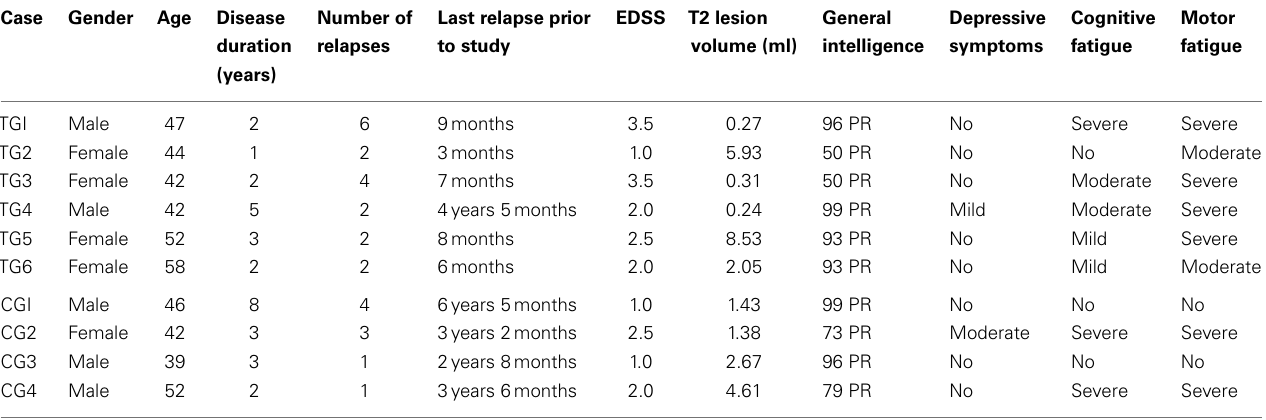
Table 1 | Baseline characteristics and possible factors for treatment response